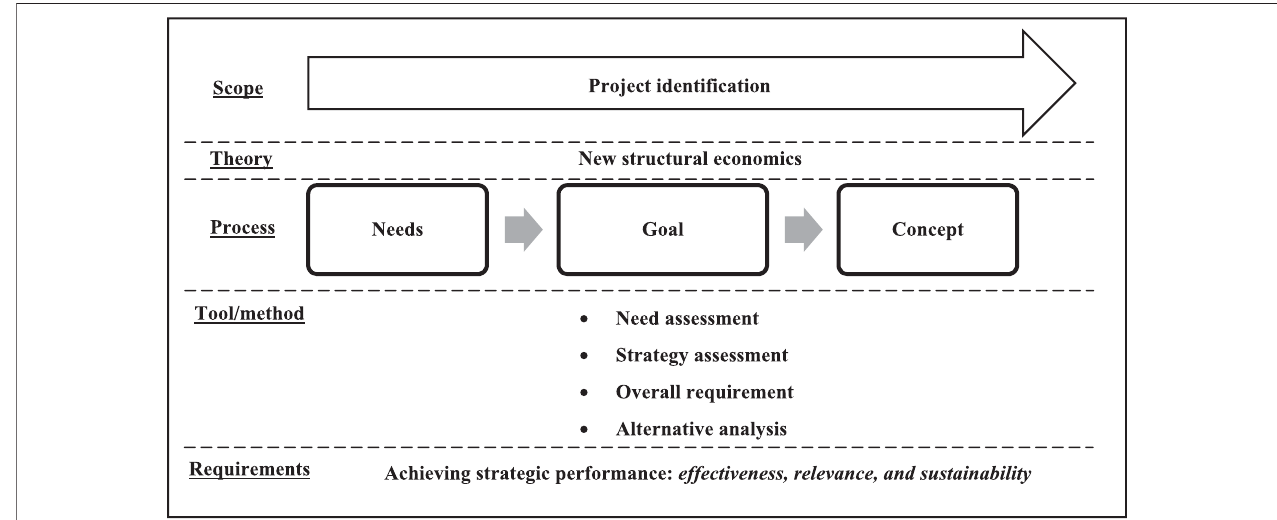
FIGURE 4 | De fi ning the elements of